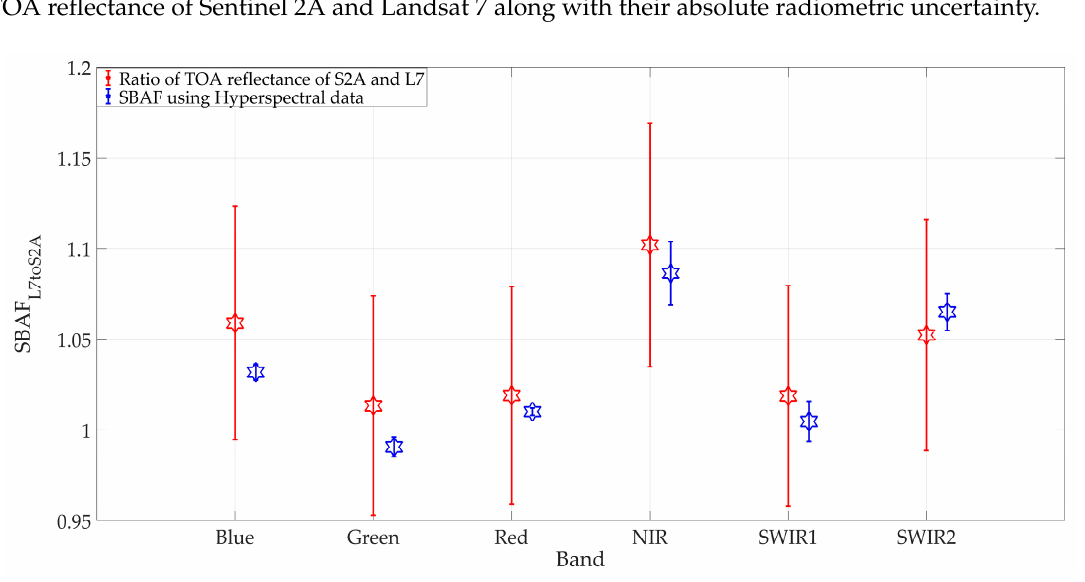
Figure 21. Plot of simulated multispectral SBAF / Multispectral TOA Reflectance Ratio Comparison (1 sigma).